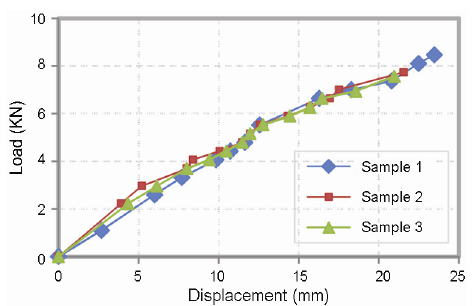
Fig. 13. Load-displacement curves for FRP-strengthened speci- mens with one layer of GFRP and with longitudinal grooves of 6 mm